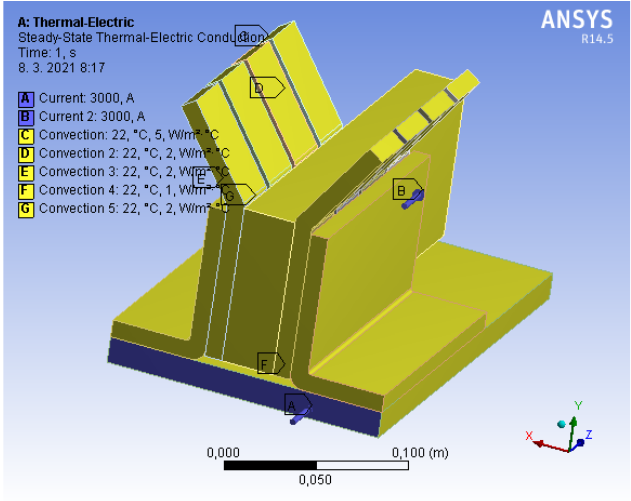
Figure 3. The contact model shows electrical and thermal conditions (points A, B are representing electric current, whereas C–G represent thermal convection). electric current, whereas C–G represent thermal